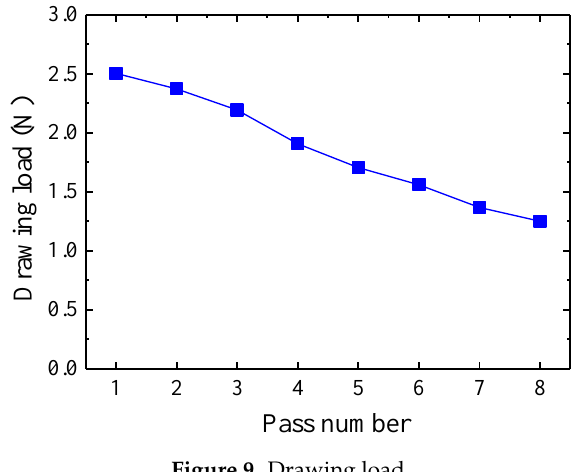
Figure 9. Drawing load.